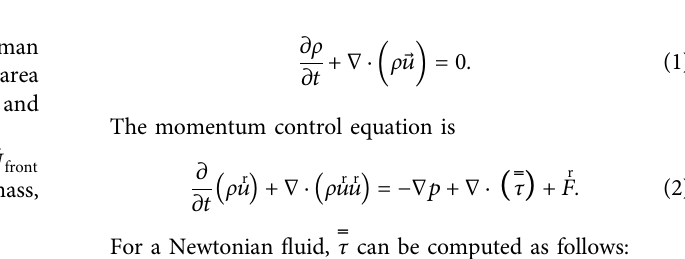
Frontiers in Energy Research |